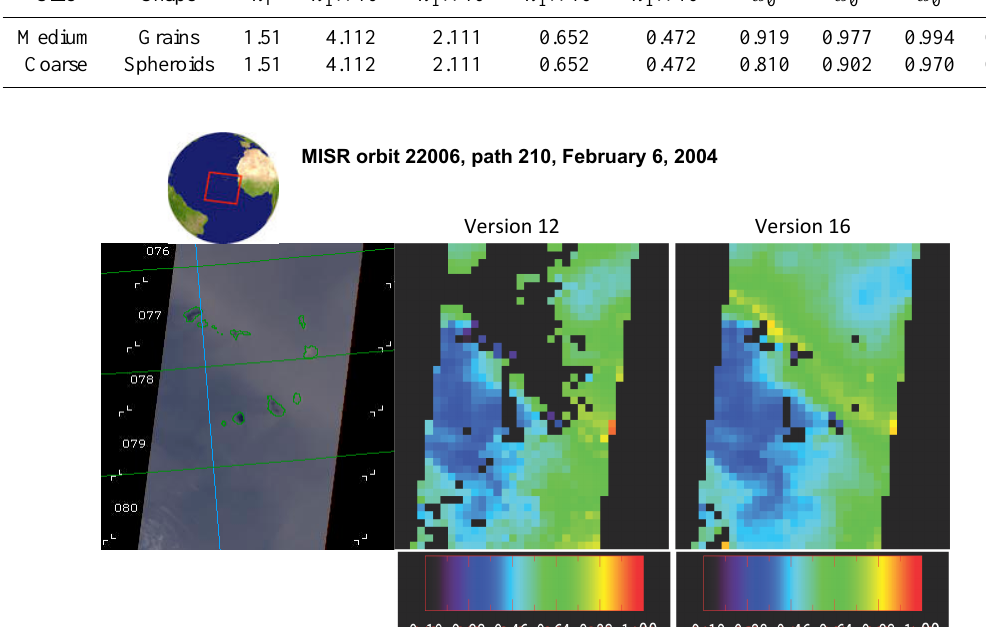
Fig. 2. Example MISR scene of dust over the Atlantic, Orbit 22006, Path 210, 6 February 2004, 12:15UTC. Left: true color browse image from the MISR Df ( + 70 . 5 ◦ ) camera. Center: version 12 operational MISR AOD retrievals for this region before the incorporation of the current non-spherical (dust) models. Right: version 16 operational MISR AOD retrievals after the inclusion of current dust